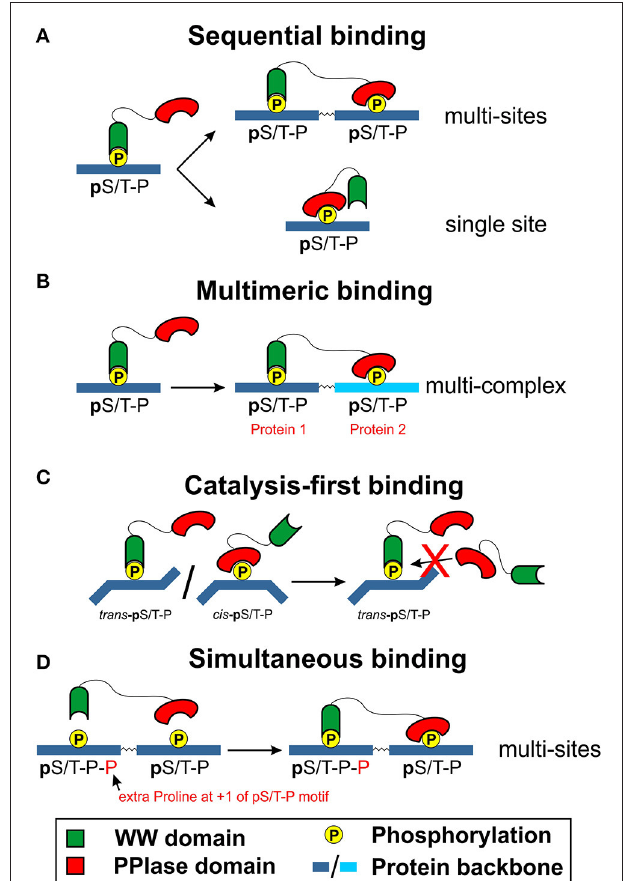
FIGURE 3 | Proposed models of WW domain and PPIase domain interaction with the substrate of Pin1 [first highlighted by Innes et al. (65)]. Two decades of research has shed light on the potential mechanism as to how the WW and PPIase domains could be involved in substrate binding of Pin1. (A) Sequential binding model. The sequential binding model involves the initial binding of the WW domain of Pin1 before the PPIase domain could bind to the same pS/T-P motif or another pS/T-P motif on the same protein. (B) Multimeric binding model. The WW domain first binds to an active kinase with a pS/T-P motif before being brought close to a substrate of Pin1. The active kinase then phosphorylates S/T-P motif to allow the PPIase domain to bind to it to initiate the isomeric reaction. (C) Catalysis-first binding model. Existing trans pS/T-P motif will be bound to the WW domain of Pin1, while the PPIase domain could bind to the cis pS/T-P motif to catalyze the isomeric reaction to the trans configuration. Subsequently, the WW domain would then bind to the new trans pS/T-P motif to prevent the reverse conversion. (D) Simultaneous binding model. Both WW domain and PPIase domain can bind simultaneously, with the WW domain binding to pS/T-P-P motif and PPIase domain binding to the pS/T-P